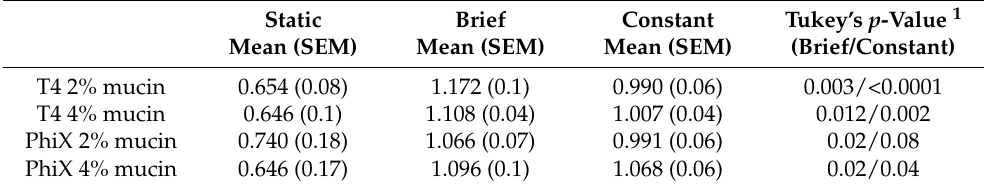
Table 4. Experimental means of phage containing 2% and 4% mucin samples at MOI